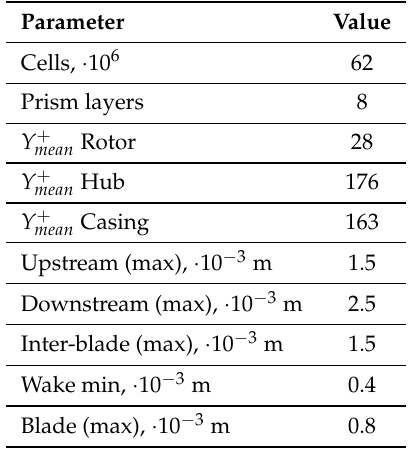
Figure 1. Geometry of the computational domain. Table 1. Grid parameters.